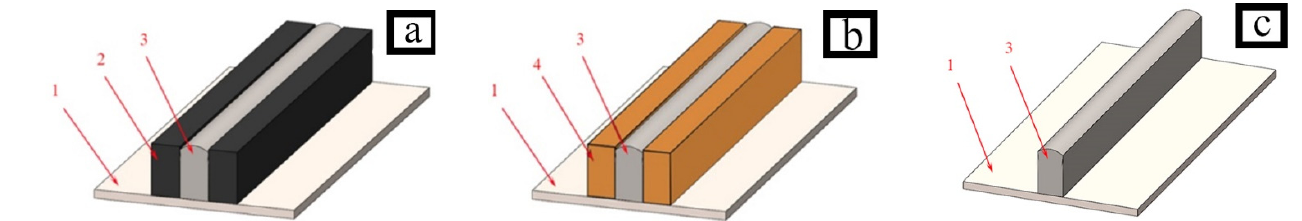
Figure 1. Isometric view of workpieces models obtained by multilayer build-up welding in a protective gas atmosphere: ( a ) using heat-transfer limiters (shaping graphite blocks); ( b ) using heat-removing limiters (shaping copper blocks); ( c ) without t limiters. 1—stainless steel substrate, 2—graphite shaping blocks (heat-transfer limiters), 3—build-up welded multilayer specimen, 4—copper shaping blocks (heat-removing limiters).